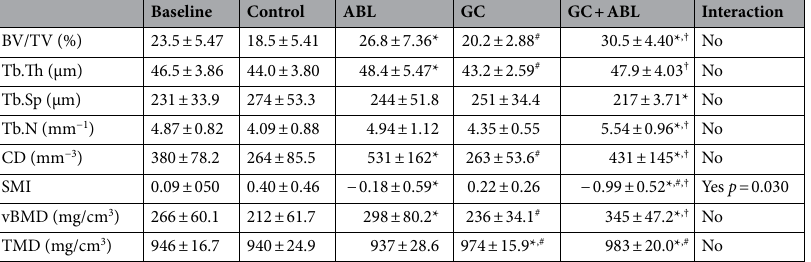
Dynamic bone histomorphometry and histological assessment of bone cells. with Control (Fig. 4). GC decreased MAR (− 31%), BFR/BS (− 40%), OS/BS (− 74%), and Ob.S/BS (− 66%) and increased Tetra.S/BS (+ 109%) compared with Control (Fig. 4). Animals in the GC group treated with ABL had lower MAR (− 19%), OS/BS (− 72%), and Ob.S/BS (− 57%) compared with Control (Fig. 4). Neither ABL nor GC affected Oc.S/BS. Furthermore, MAR (− 34%), BFR/BS (− 34%), OS/BS (− 76%), and Ob.S/BS (− 67%) were